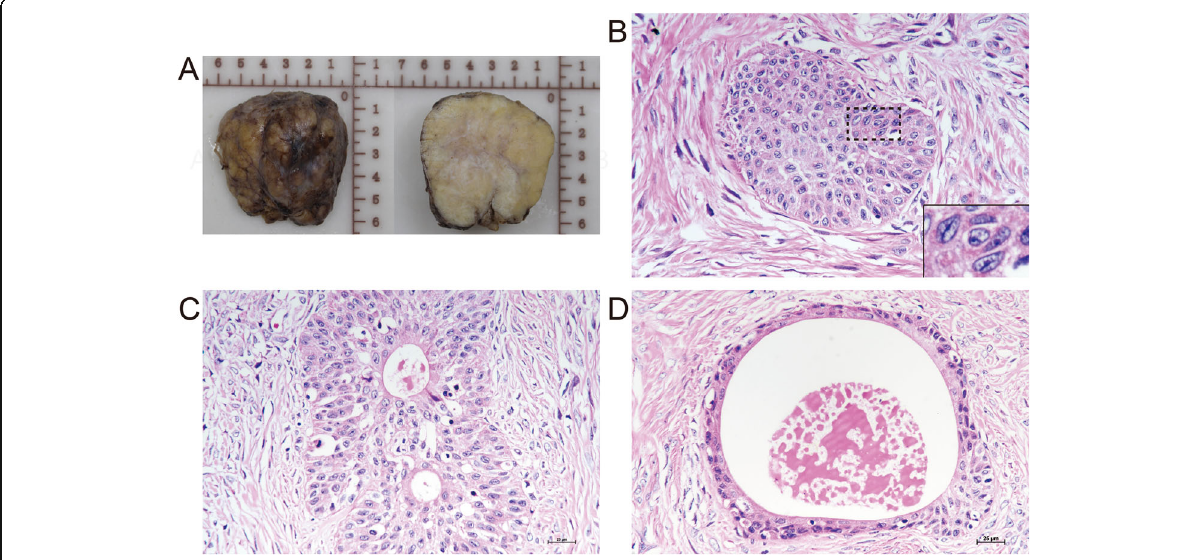
Fig. 2 Histopathological features of EOBTs. A nodule lesion with yellowish-gray cut surface ( a ). The well-defined epithelial nests consisted of urothelium-like cells with clear to eosinophilic cytoplasm and longitudinal nuclear grooves ( b ). Cavities in epithelial islands were lined by a single layer of umbrella-like cell ( c ). Some cell nests resembled their counterparts in WNs ( d ). Original magnification x